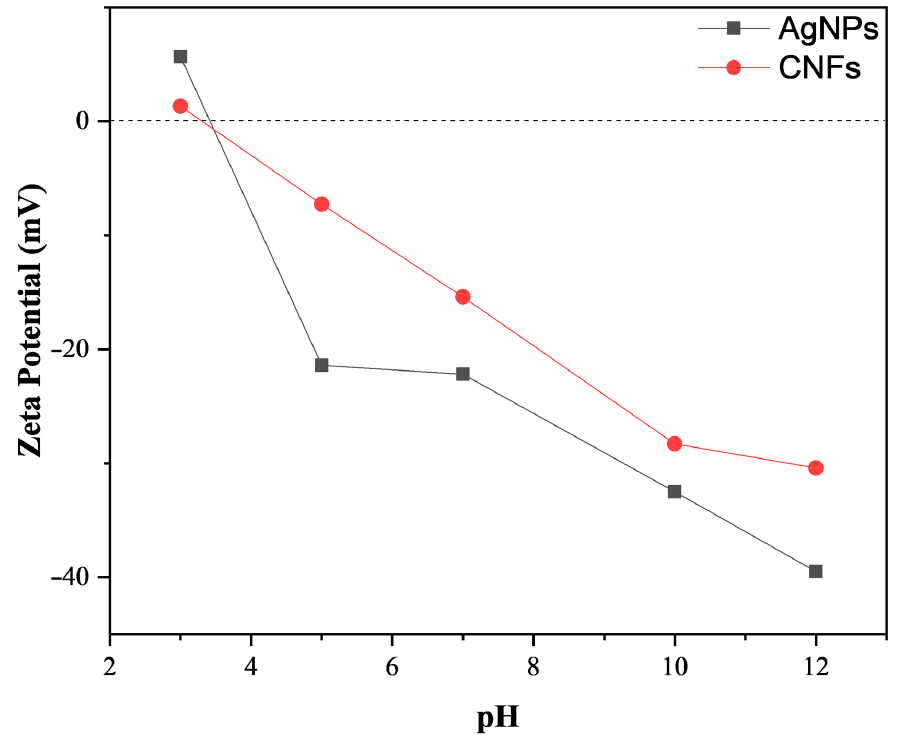
Figure 2. Zeta potential ( ζ ) in mV of silver nanoparticles (AgNps) and carbon nanofibers (CNFs) as a function of pH in a water solution. The Raman spectra of the two chemically different nanomaterials (metallic nano- material versus carbon-based nanomaterial) are shown in Figure 3.